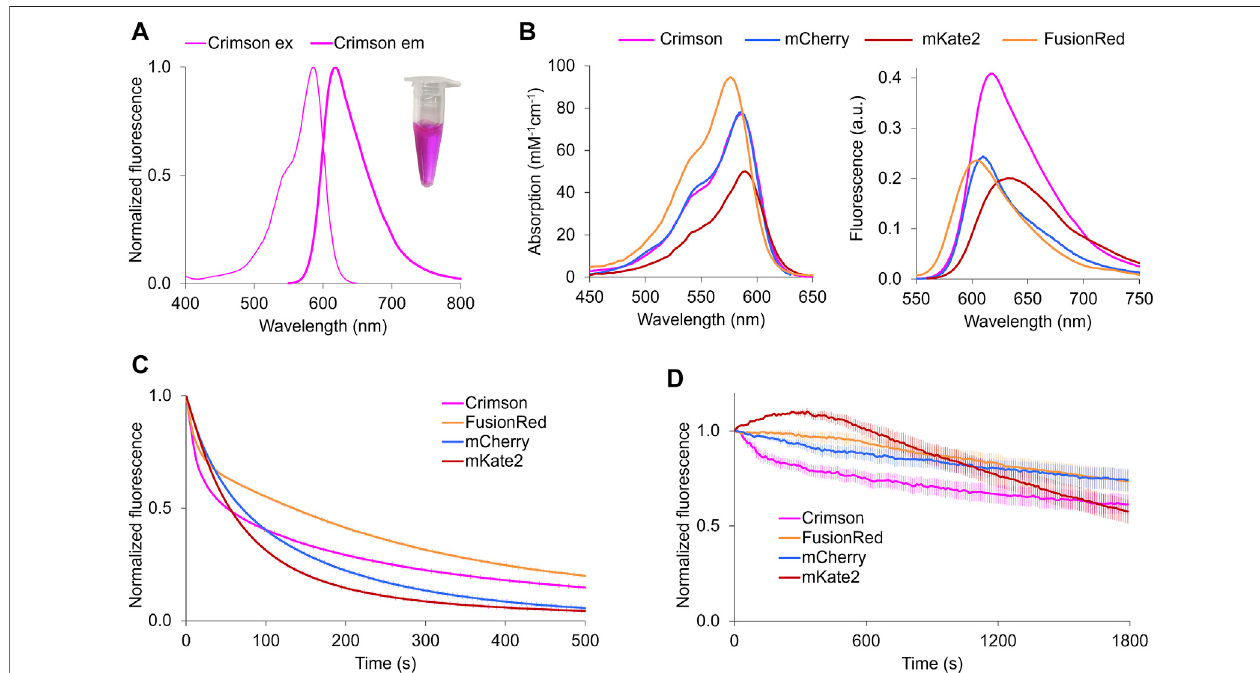
FIGURE 1 | Characterization of Crimson in vitro and neurons. (A) Fluorescence spectra of Crimson. Inset, puri fi ed Crimson in visible light. (B) Absorption (left) and emission(right)ofRFPswithexcitationmaxima at 580 – 590 nm.Absorbancespectraare scaledtopeak extinction coef fi cient. Emission spectraarescaled sothatareas under the curves are proportional to peak brightness (product of peak extinction coef fi cient and quantum yield). (C) Photobleaching kinetics of puri fi ed RFPs under arc lamp illumination with a 568/20-nm excitation fi lter. Time is scaled so that emission is normalized to 1000 photons per s. Imaging interval = 1 s. Each curve is the mean of two independent experiments with the error bars denoting SD (standard deviation, n ≥ 6). (D) Photobleaching of RFPs in transfected neurons under 585-nm laserillumination.Fluorescentintensityofeachtimeframeissubtractedagainstthebackgroundandnormalizedtotimepoint0.Imaginginterval=10 s.Eachcurveisthe mean with the error bars denoting SD ( n =